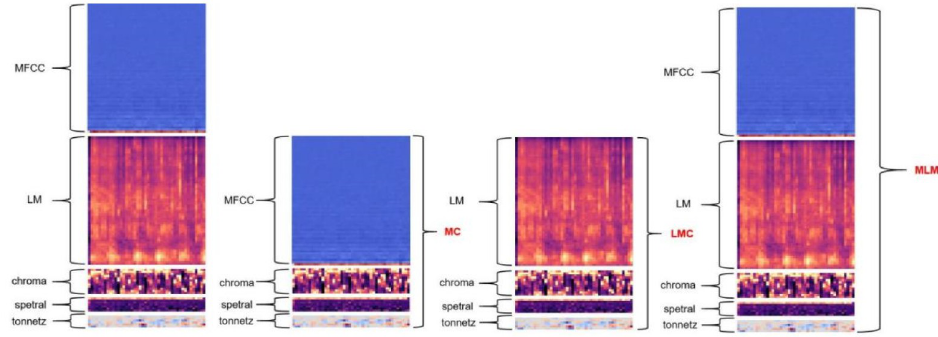
Fig 4. Feature map. (a) Five categories of essential feature. (b) Combined features obtained based on basic features.